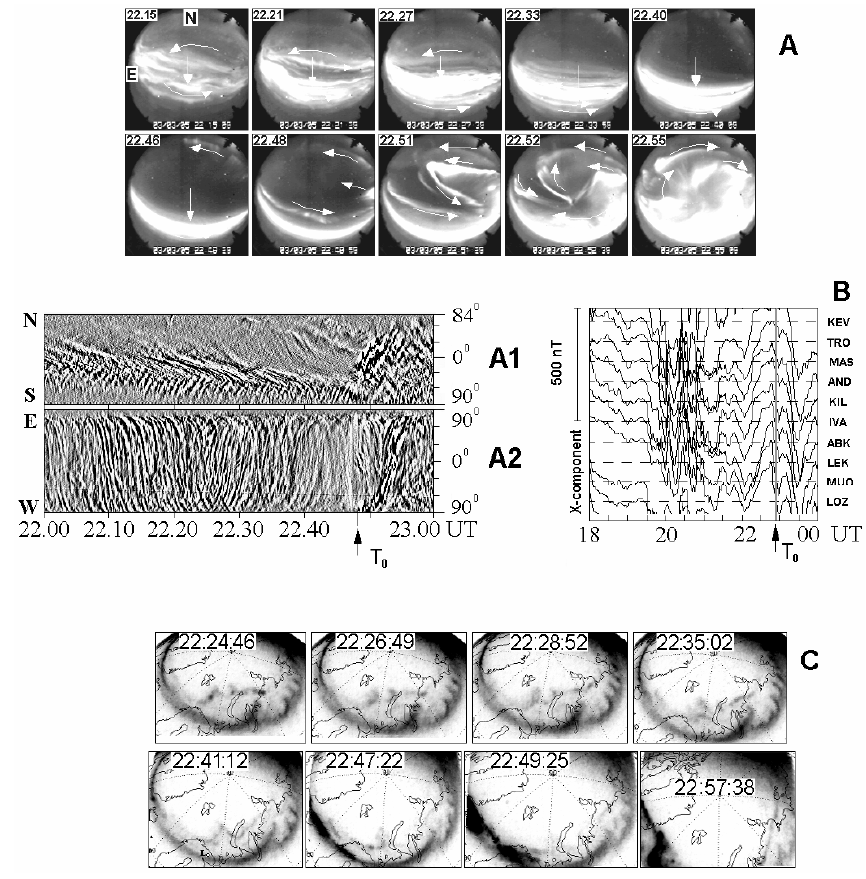
Fig. 3. Sample of data for a strong auroral activity event on 5 March 2003. Panels (A) , (A1) , (A2) , (B) are the same as in Fig. 1, panel (C) has auroral images from the IMAGE spacecraft. Universal times are indicated in each auroral